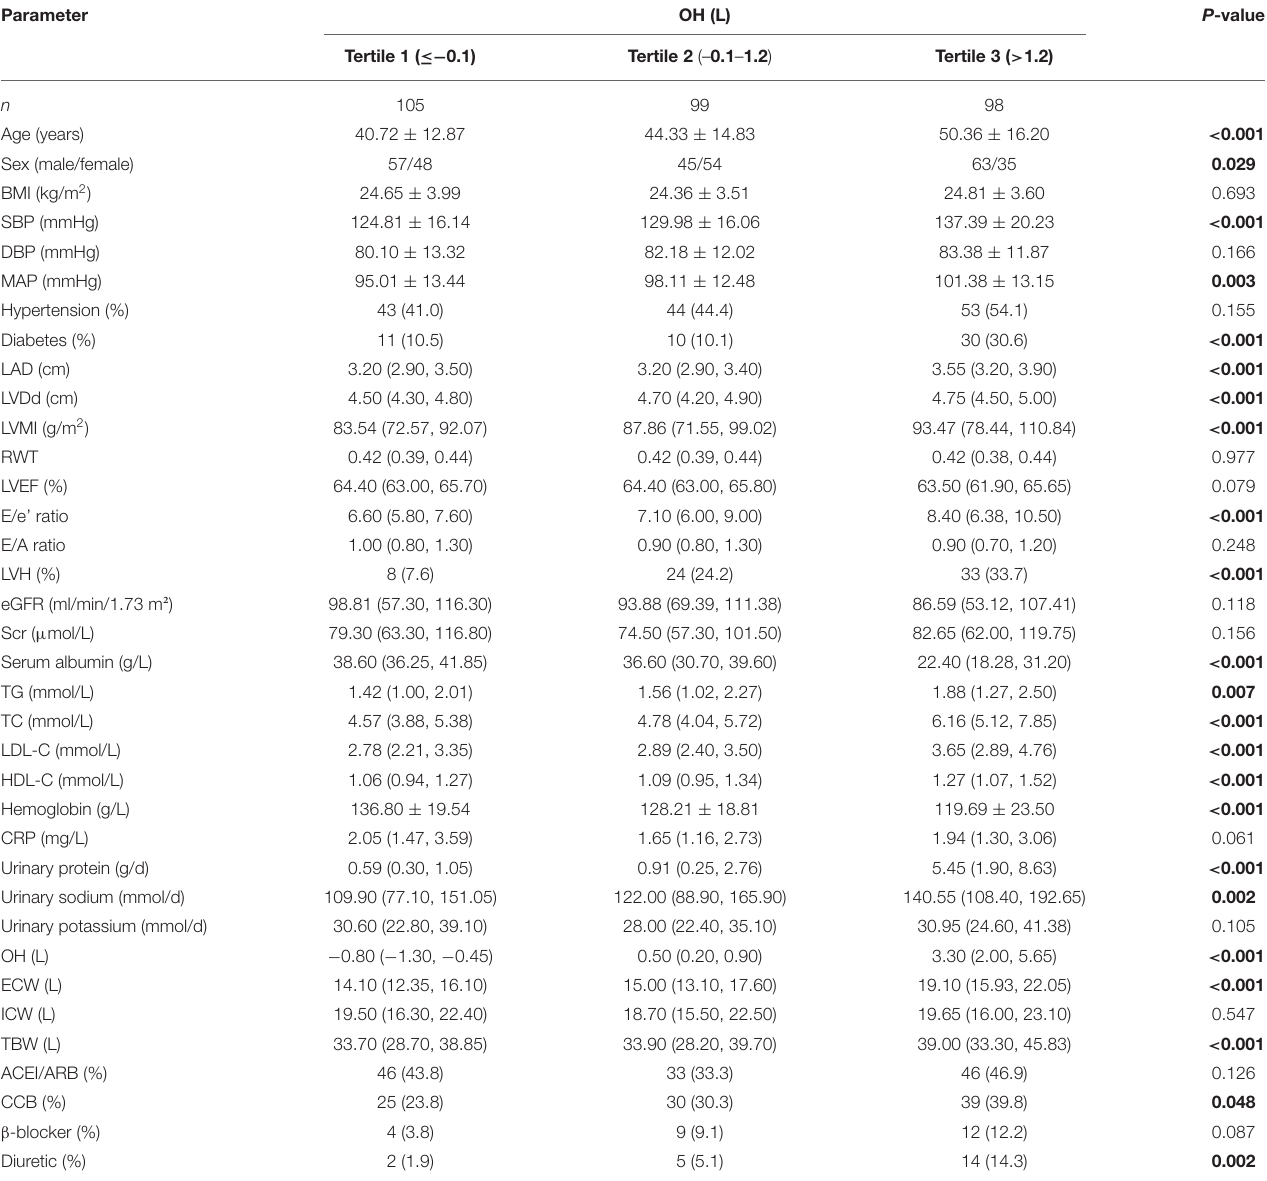
TABLE 2 | Comparisons of clinical, laboratory, and echocardiographic parameters and volume status according to OH tertiles in patients with CKD. Parameter OH (L) P -value Tertile 1 ( ≤−